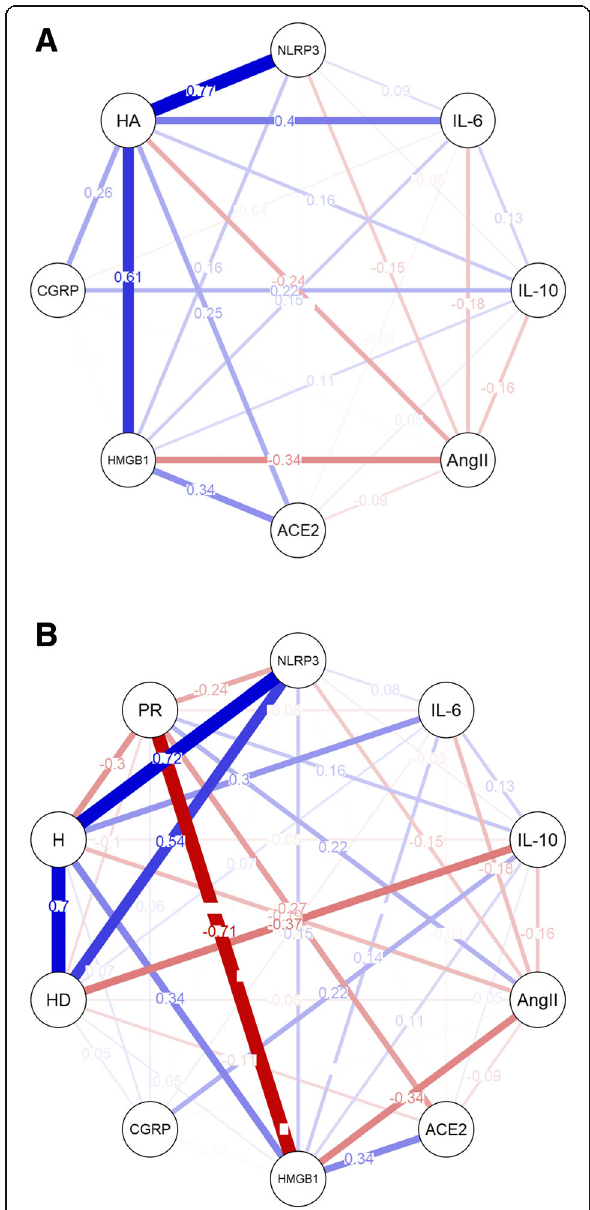
Fig. 3 Network analysis models of the interrelationships among inflammatory molecules, headache (HA), headache duration (HD), hospitalization (H) and paracetamol response (PR) in COVID-19 patients with headache ( n = 48). Headache was positively correlated with serum levels of NLRP3, HMGB1, IL-6 and ACE2 and these relationships were greater than the others ( A ). Serum HMGB1 level was negatively correlated with paracetamol response (w = − 0.71) (B). Hospitalization (w = 0.72) and headache duration (w = 0.54) were positively correlated with NLRP3 level ( B ). Line thickness denotes weight of the correlation, blue and red colors represent positive and negative correlations,